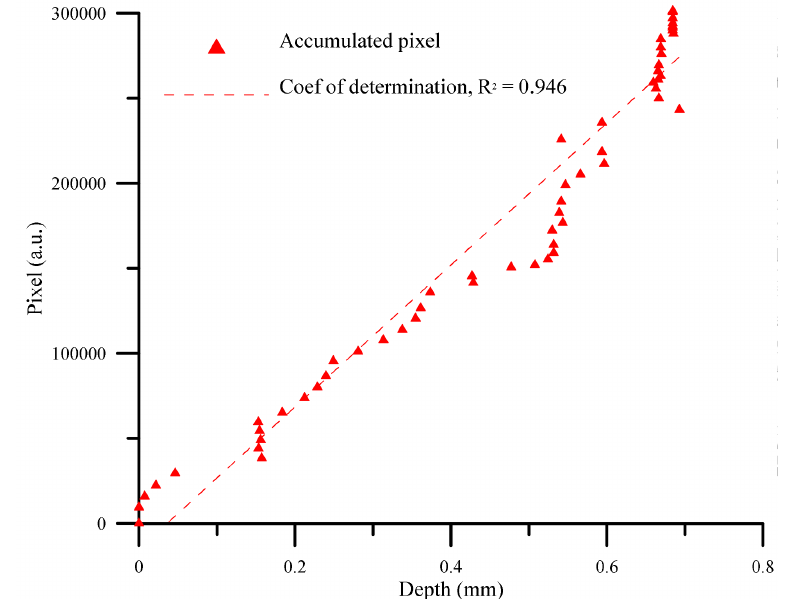
Figure 10. The correlation between the deepness of the SACE-drilled hole and the pixels of the arcing plasma area, acquired by using a radially mounted industrial camera.